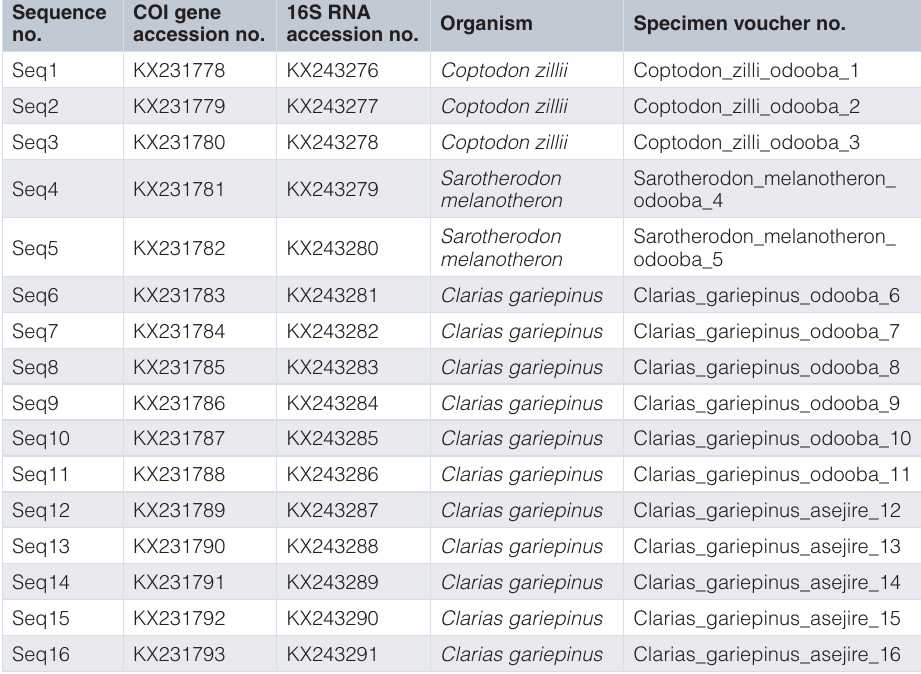
Table 2. Genbank accession numbers for COI and 16S gene sequences for the different fishes. Sequence